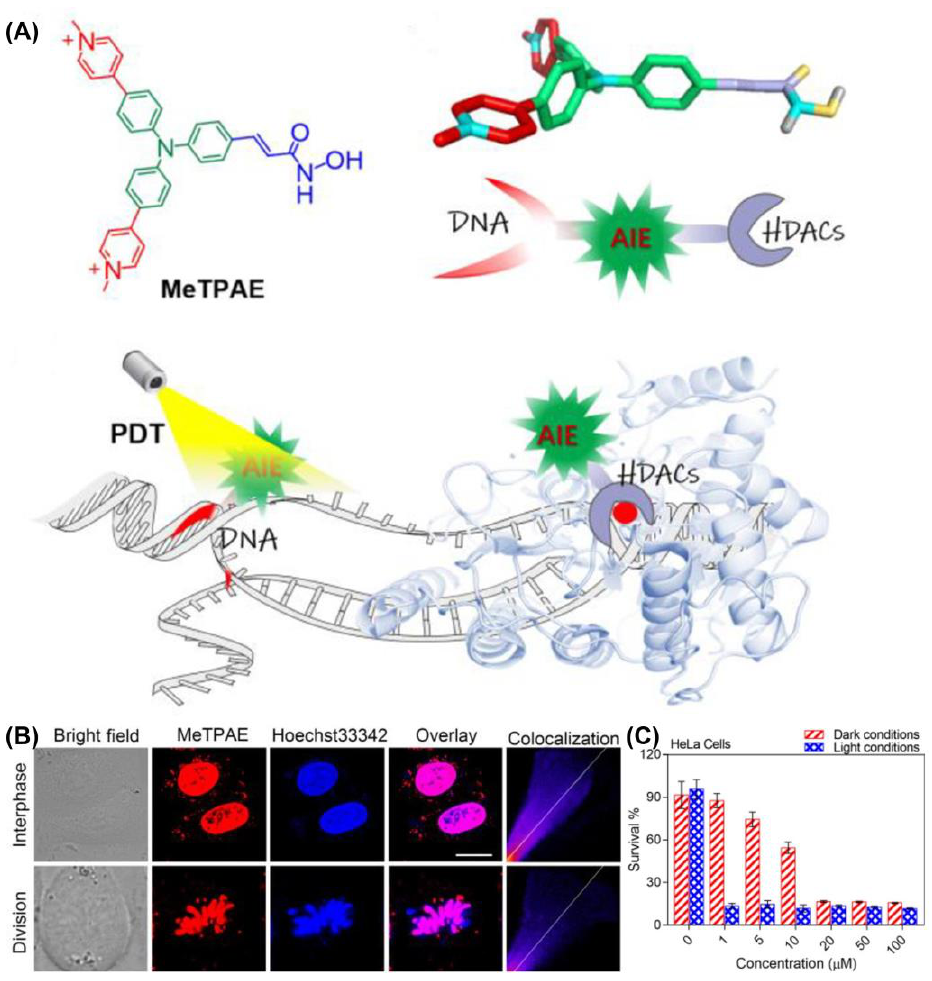
Figure 17. ( A ) Schematic illustration of chemical structure and mechanisms of MeTPAE with nucleic acids and histone deacetylase; ( B ) colocalization images of MeTPAE and Hoechst 33342 in HeLa cells during cell interphase or division; ( C ) cell viability of HeLa cell after being treated with MeTPAE. Reprinted with permission from Ref. [130]. Copyright 2022 WILEY-VCH.